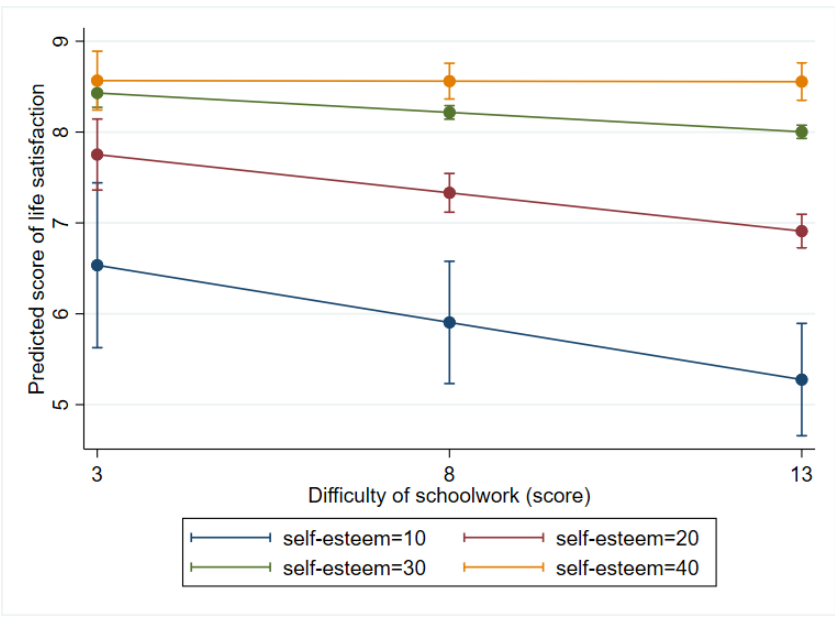
Figure 3. Marginal effects of the difficulty of schoolwork on life satisfaction at different levels of self-esteem.